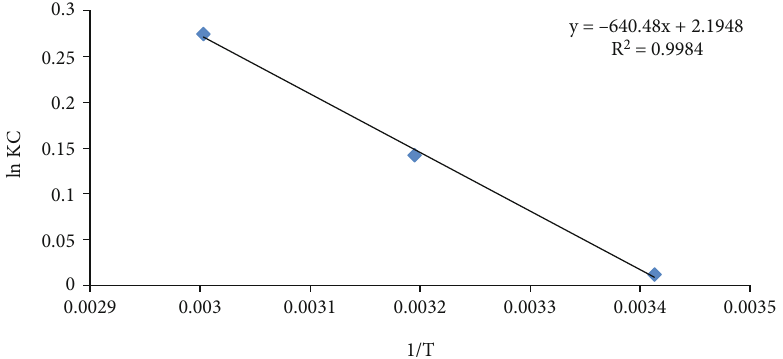
y = –640.48x + 2.1948 R 2 = 0.9984